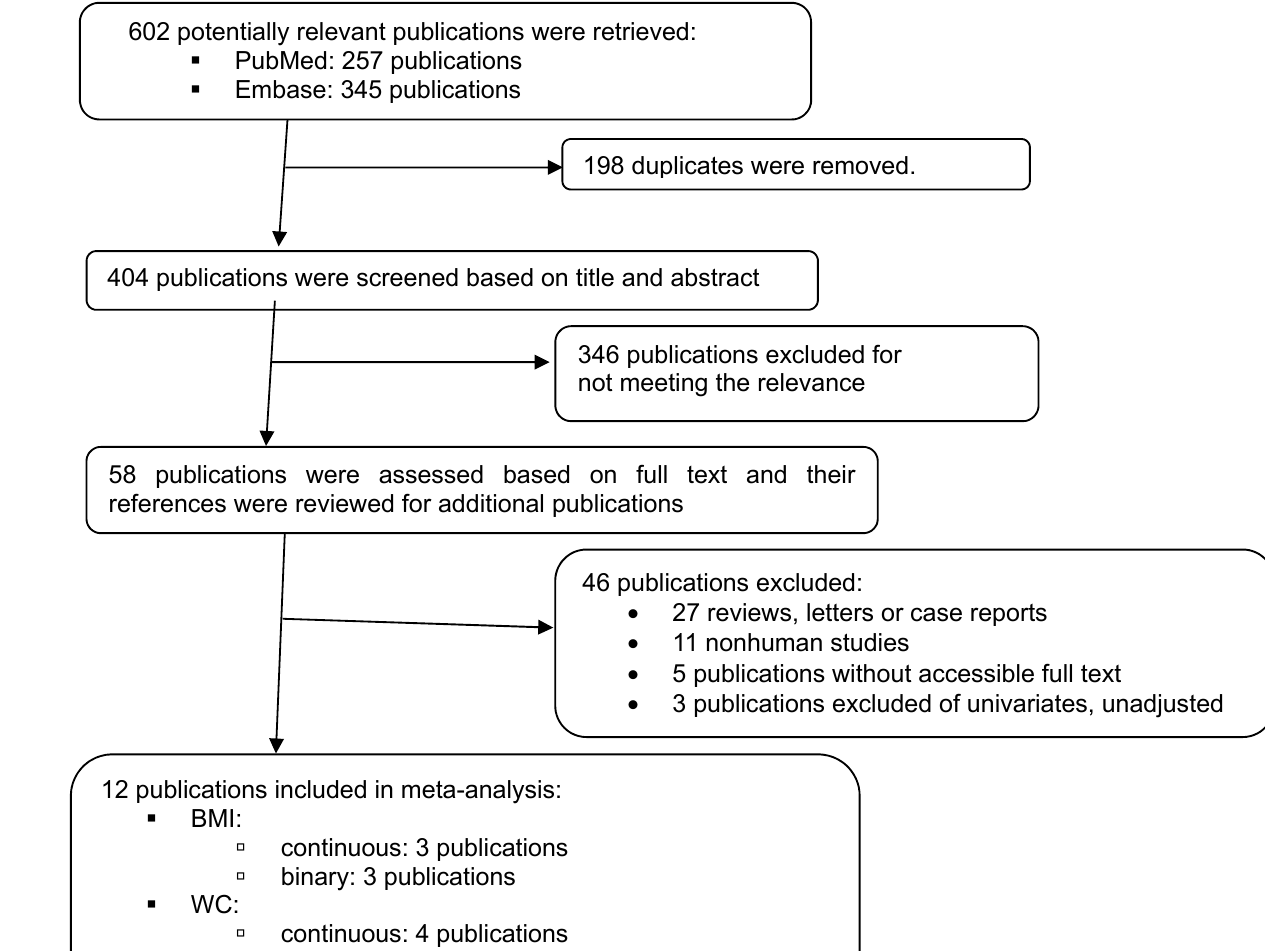
Figure 1. Flowchart for study selection.